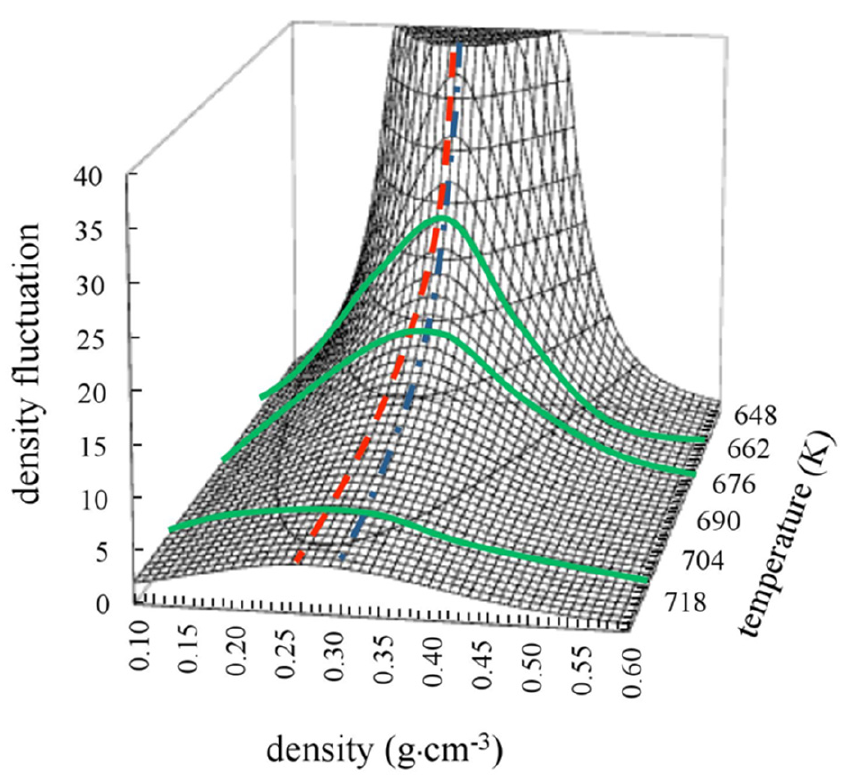
Figure 2. Behavior of the density fluctuation of SCW on the ρ − T phase diagram evaluated from the equation of state of Wagner et al. [26]. The green curves are the isotherms of density fluctuation at T r = 1.02, 1.04, and 1.06. The Nishikawa line and the critical isodensity line are described by the red broken line and blue chain line, respectively.